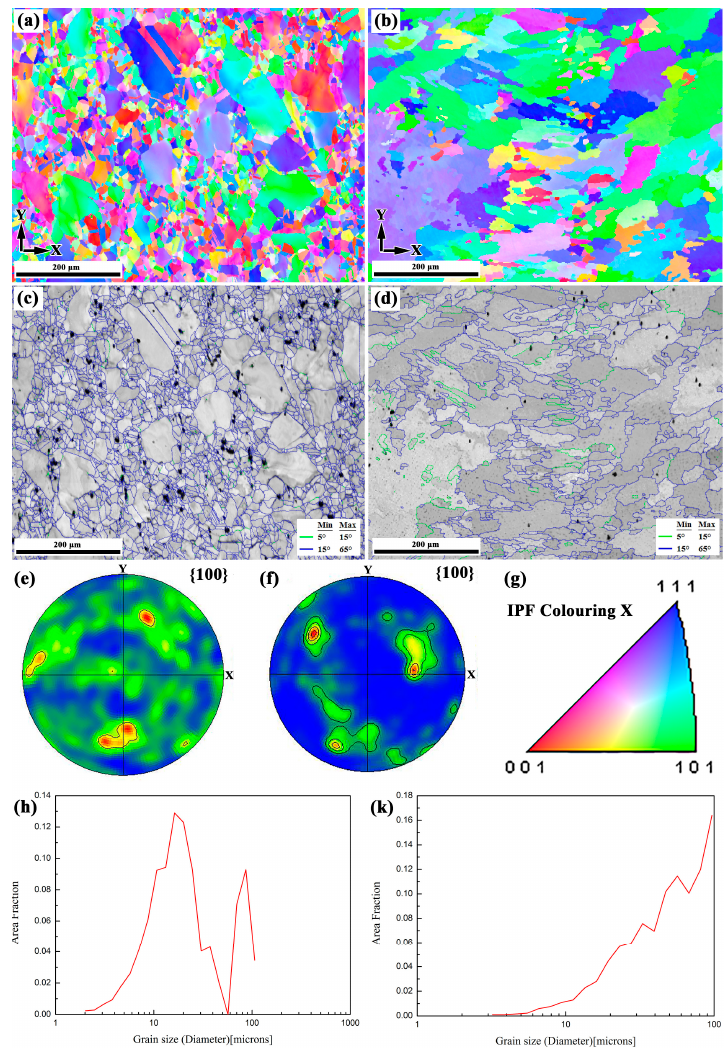
Figure 6. EBSD results of LARed Inconel 625 samples of the substrate zone (SZ) ( a )( c )( e )( h ) and the repaired zone (RZ) ( b )( d )( f )( k ) in the X–Y section: ( a )( b ) IPF orientation maps, ( c )( d ) band contrast maps, ( e )( f ) {100} pole figures, ( g ) IPF and ( h )( k ) grain size distribution.